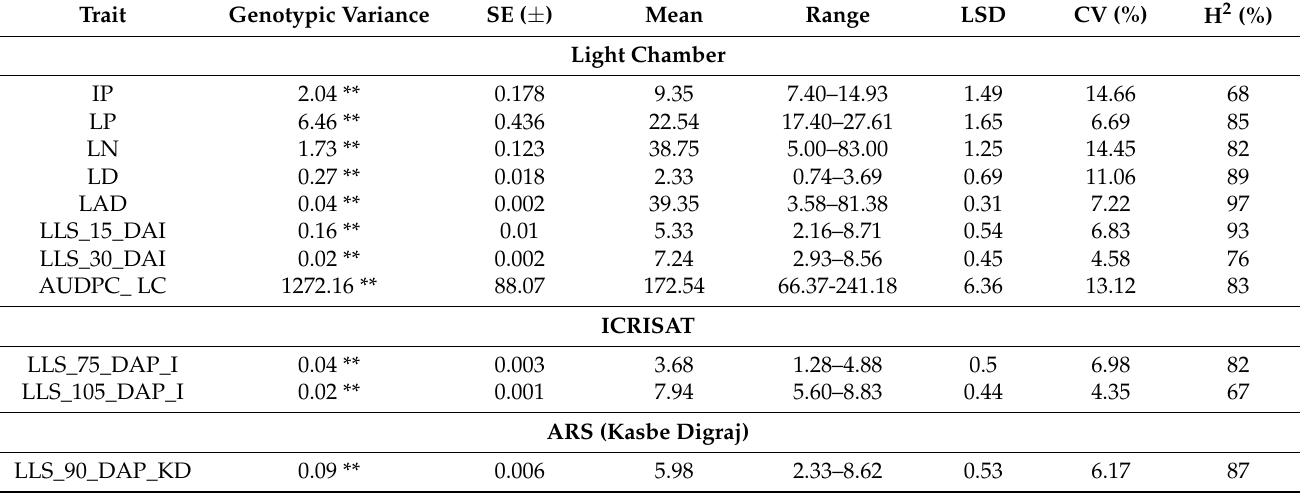
** significance at 1% level of probability. The trait mean values of parents, checks and MAGIC population and the trait range in the MAGIC population are summarized in Table 4. Among the parents, the genotype ICGV 91114, which is a LLS susceptible parent showed shortest IP (7.74 days) and LP (17.40 days) highest values for LN (41.06), LD (2.66 mm), LAD (52.05%), LLS_15 DAI (7.77), LLS_30 DAI (8.19), AUDPC_LC (222.45), LLS_105 DAP_I (8.74) and LLS_90 DAP_KD (7.38). Conversely, the resistant parent, GPBD 4, recorded long IP (11.51 days) and LP (27.61 days) and low values for LN (5), LD (1.68 mm), LAD (3.94%), LLS_15 DAI (2.61), LLS_30 DAI (3.36), AUDPC_LC (72.61), LLS_75 DAP_I (2.26), LLS_105 DAP_I (6.89) and LLS_90 DAP_KD (4.53). Among the checks, GG 20 and JL 24 were susceptible and recorded an IP of 8.42 days. The disease scores of GG 20 were: LLS_15 DAI (7.80), LLS_30 DAI (7.82), and LLS_105 DAP_I (7.14), and high AUDPC_LC (216.21). Disease score in the susceptible parents, ICGV 91114, GG 20 and JL 24 indicated good disease pressure in the experiments conducted in light chamber and field disease nursery at both the locations. Large variation for all the traits measured in light chamber and field conditions was observed in the MAGIC population (Table 4). The IP and LP among the 600 MAGIC lines ranged from 7.40 to 14.93 days, and from 17.40 to 27.61 days, respectively indicating large variability for appearance of first symptom and first sporulation lesion. The lesion numbers varied from 5.51 to 83.06 per leaf, and the lesion diameter varied from 0.73 to 3.69 mm. Similarly, large variation was observed for LAD, which varied from 3.58% to 81.38%. The AUDPC_LC values among the MAGIC population ranged from 66.37–241.18. The LLS scores at different days after inoculation (DAI) at light chamber and different days after planting (DAP) at field such as LLS_15 DAI, LLS_30 DAI, LLS_75 DAP_I, LLS_105 DAP_I and LLS_90 DAP_KD were in the range of 2.16–8.56, 2.93–8.56, 2.15–4.88, 5.60–8.83 and 2.83–8.62,